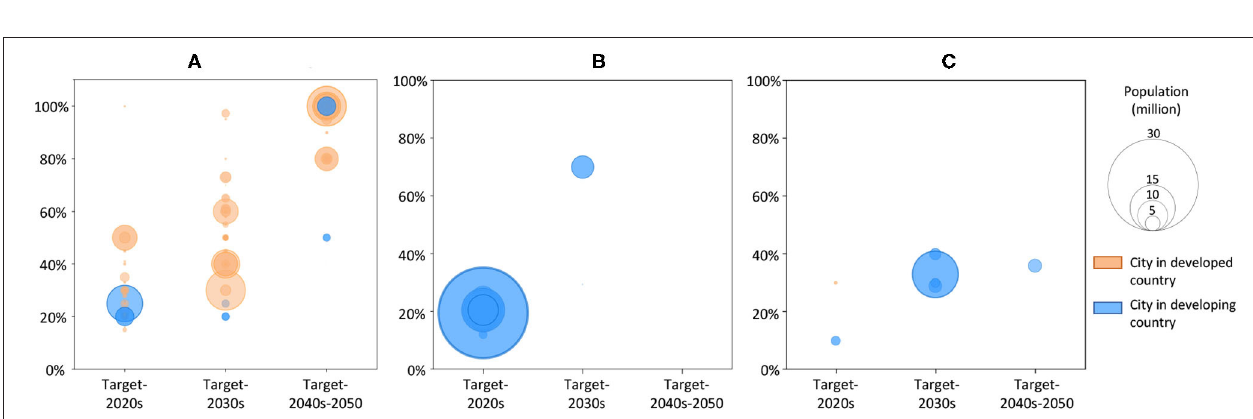
Curitiba; 41, Rio de Janeiro; 42, Venice.